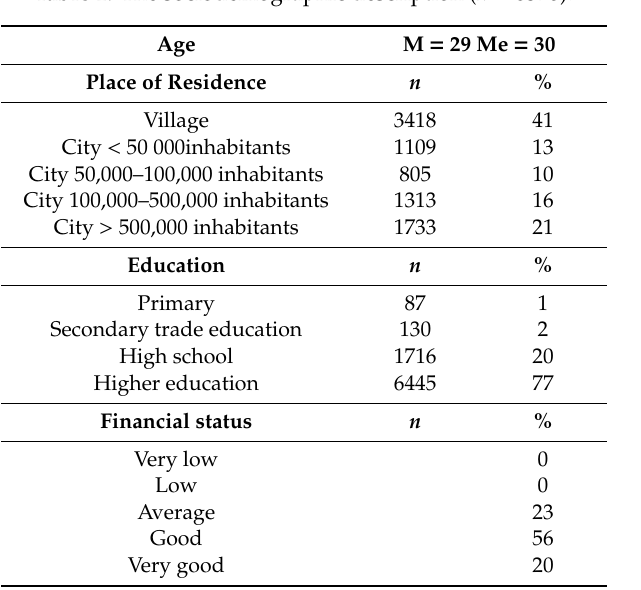
Table 1. The sociodemographic description ( n = 8378).